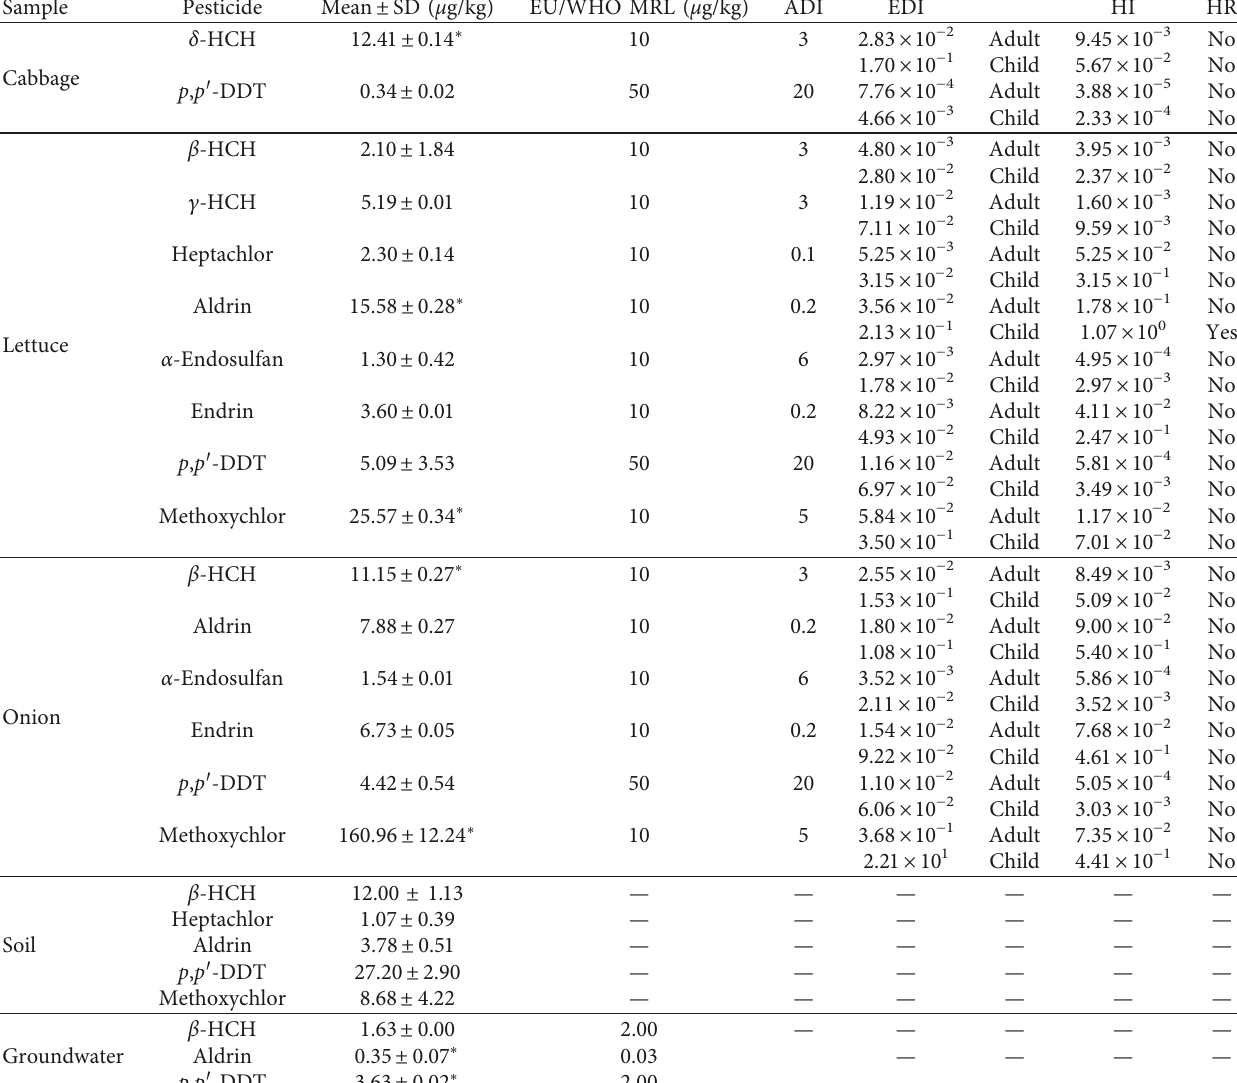
Table 3: Concentrations, EDI, and health risk estimation for OCP residues detected in vegetables from Gyenyase.